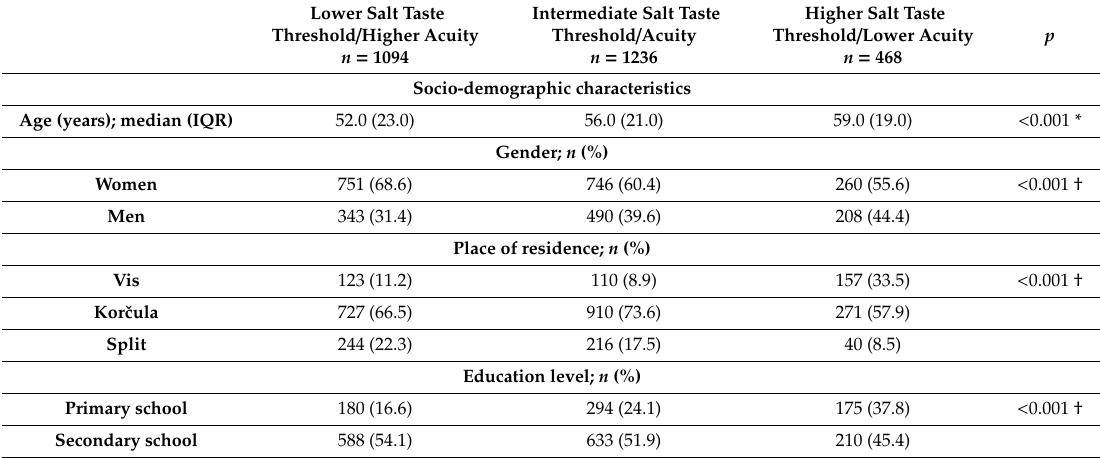
Table 1. Subjects’ characteristics according to the salt taste recognition threshold